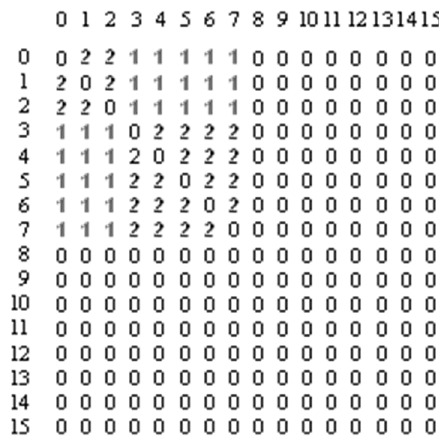
Figure 1. Illustration of entries of matrix A ( n = 16, m = 8, m 1 = 3). In other words, we have a grid (rectangle) of dimensions n 1 × n 2 (for simplicity, n 1 = n 2 ). More precisely, we have n = n 1 × n 2 squares (dots, points) of identical size. For convenience, it may be recommended that n be equal to 2 raised to a power λ , i.e., 2 λ (for ex- ample, 2 6 , 2 8 , and so on). The squares are evenly positioned in n 1 horizontal lines and n 2 ver- tical columns. There are m 1 squares of color color 1 (say, red). Also, there are m 2 = m − m 1 squares of color color 2 (for example, green) and also m 3 = n − m = n − m 1 − m 2 squares of color color 3 (say, blue). This forms a color mix pattern, i.e., a mixture (composition) of three colors (red, green, blue), which can be characterised by the parameters m 1 , m 2 , m 3 . Then, the aim is to obtain a configuration of all the points, i.e., a color pattern, where the colors (color squares) are distributed in the most uniform possible way. In other words, we are seeking to get fine, well-balanced color combinations; that is, we wish to obtain the most uniform possible pattern for each color (see Figure 2). It should be noted that the color mix problem is a more complex case of the grey pattern problem (GPP) [2], where one has n points in the rectangle and there are m black points, while the remaining points are white. The goal is to have a grey pattern where the black points are scattered as regularly as possible on the rectangle. ( i ) following formulas: r = p , s = p ( i ) mod n 2 , i = 0, . . . , n − 1. Note that the first m 1 n 2 placed in. The next m 2 elements define the positions of the green squares, and so on.